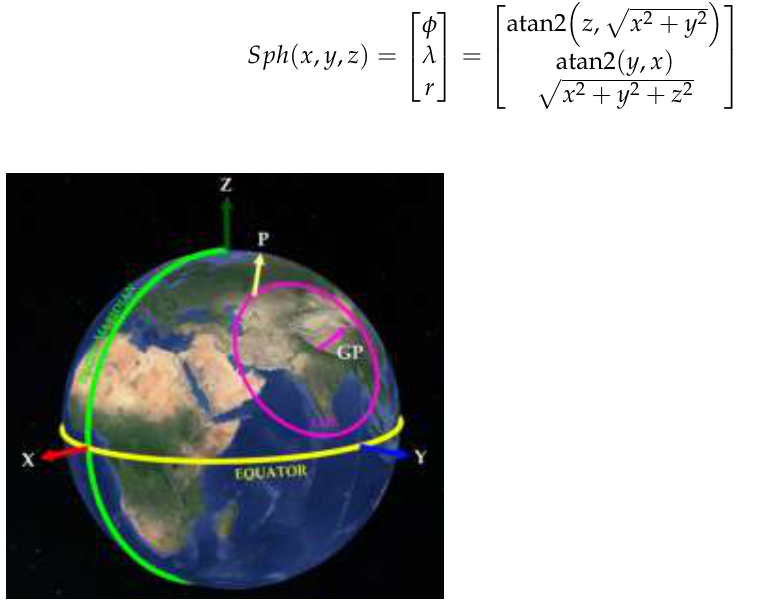
Figure 2. The CoP on the Earth-Centered Earth-Fixed (ECEF) coordinate system. Equation (2) uses the two-argument arctangent (atan2) because it can provide quadrant identification and a smaller round-off error, as compared with arcsine and arccosine.